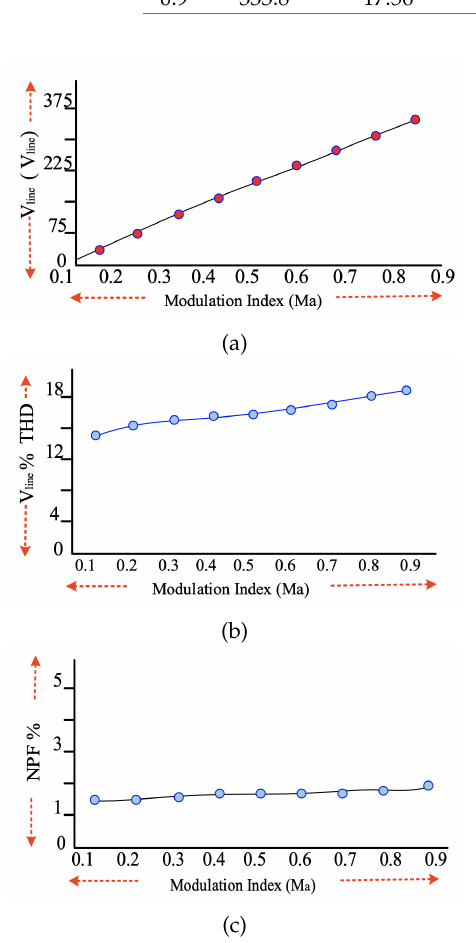
Fig. 11. Experimental results line voltage, voltage THD and NPF for different M a : (a) line voltage verses M a , (b) Line voltage THD% verses M a , (c) NPF% verses M